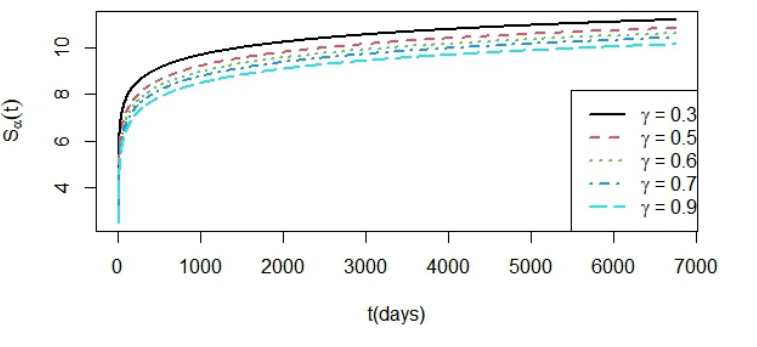
Figure 5. The entropy fractional time analysis for S & P 500 at varying γ between 0 and 1, where α = 0.38, 0.586, 0.697, 0.810, and 1.035, from Table 1, the monotonic increase of α for increasing γ is accompanied by the monotonic decrease of S ( P , t ) for increasing, demonstrating the regime’s α